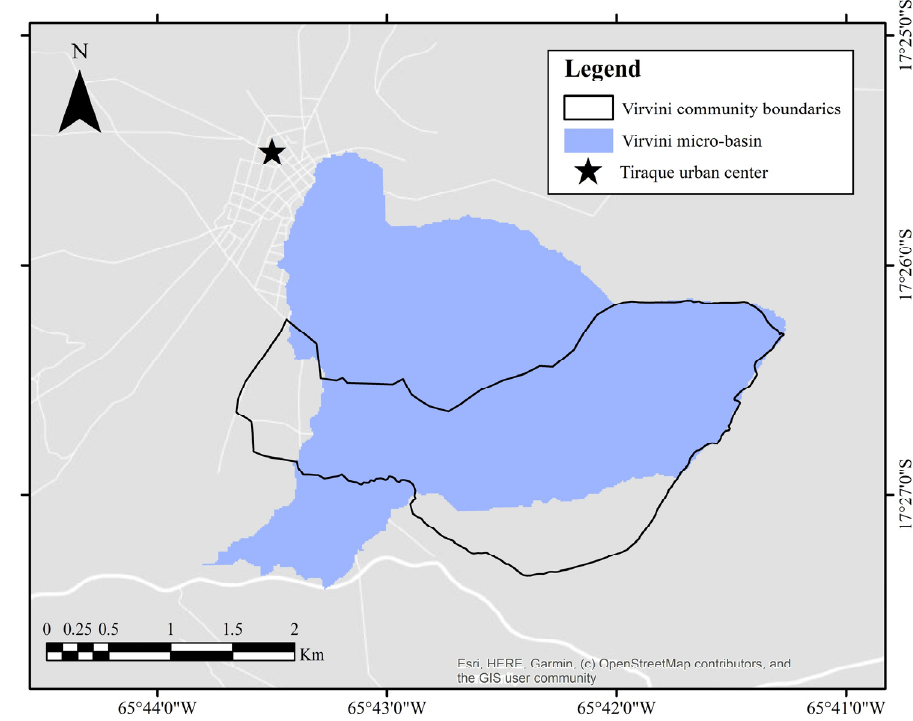
Figure 2. The delimitation of the Virvini micro-basin, based on the administrative limits of the Virvini community.